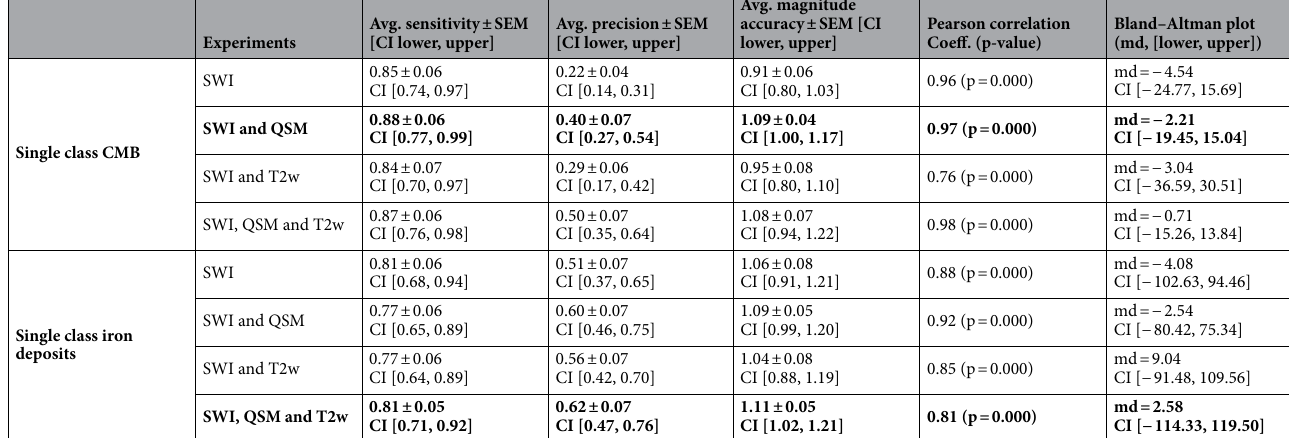
Table 1. Experimental results using the single class model for the number of predicted CMB and iron deposit lesions evaluated against the reference annotation. SEM standard error of the mean, md mean difference, CI confidence interval. Bold—Model with highest magnitude accuracy.